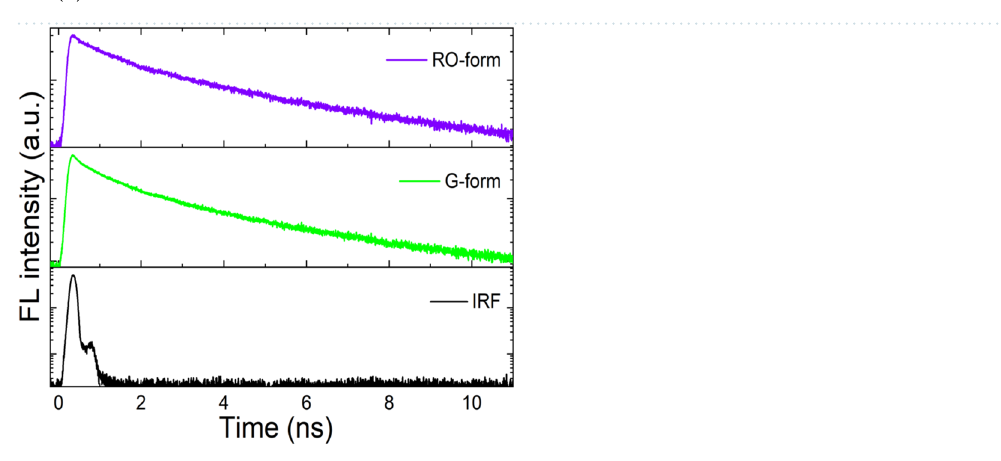
Figure 8. UV–visible absorption spectra of DSP crystals in the interconversion between ( a ) G- and O-forms and ( b ) RO- and G-forms.